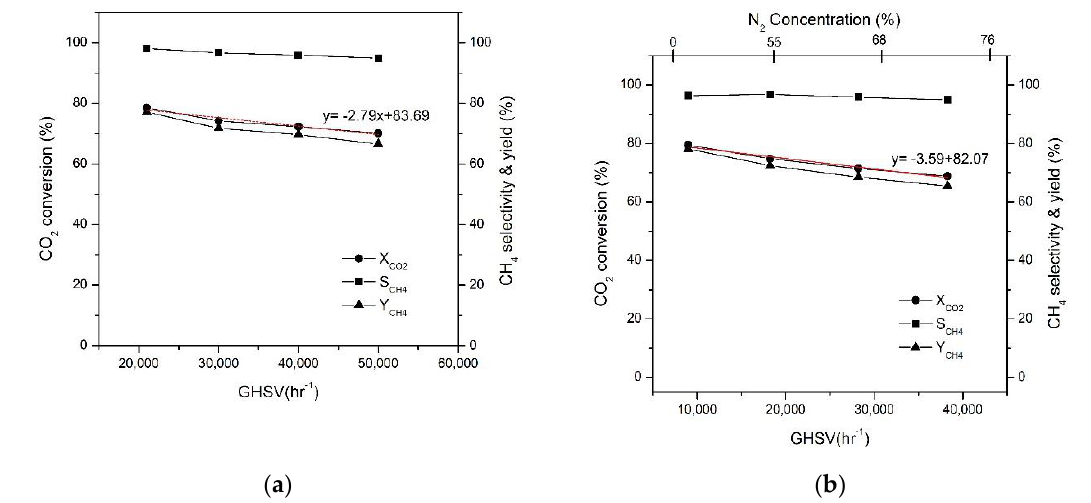
Figure 3. E ff ect of increased gas hourly space velocity and N 2 concentration at H 2 / CO 2 ratio of 4 and Figure 3. Effect of increased gas hourly space velocity and N 2 concentration at H 2 /CO 2 ratio of 4 and reaction temperature of 350 ◦ C ( a ) total reactant flow rate ( b ) N 2 flow rate (N 2 concentration). reaction temperature of 350 ° C ( a ) total reactant flow rate ( b ) N 2 flow rate (N 2 concentration).